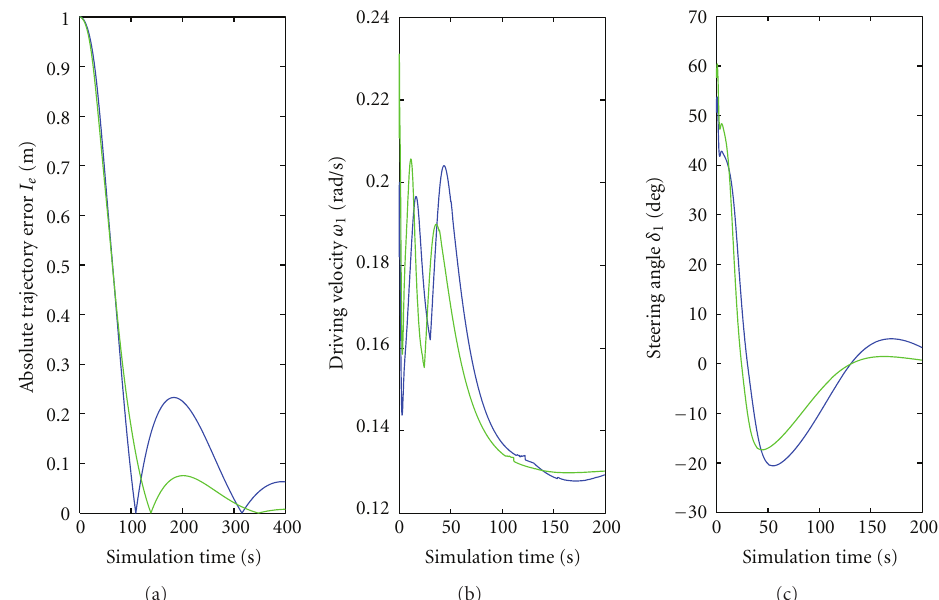
Figure 6: Tracking performance (a), angular velocity of the front-left wheel (b), and steering position of the front-left wheel (c).